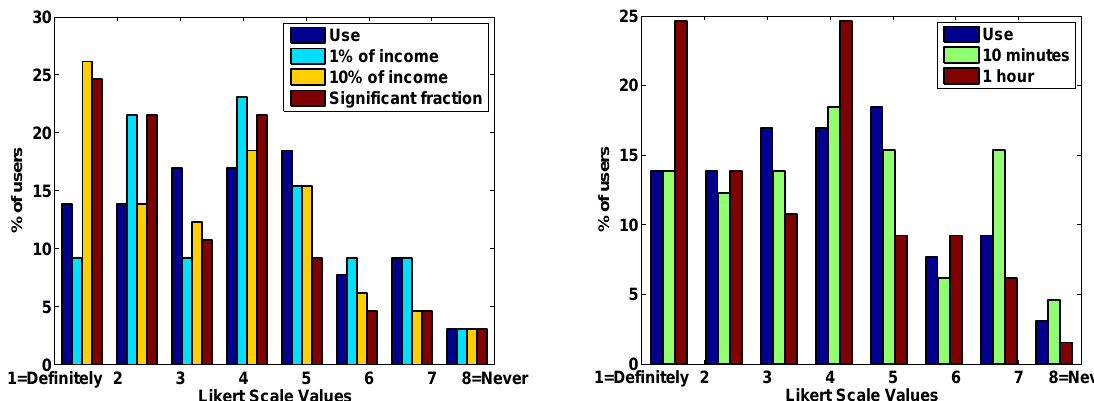
Figure 8. Responses to Brand Reputation Question (best viewed in